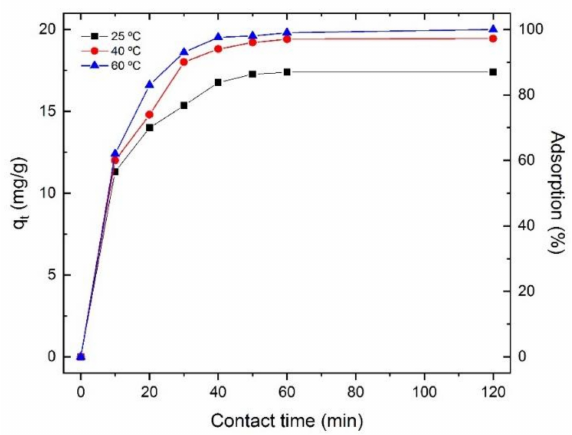
Figure 8. Influence of temperature on terbium adsorption. Other experimental conditions are as detailed in Figure